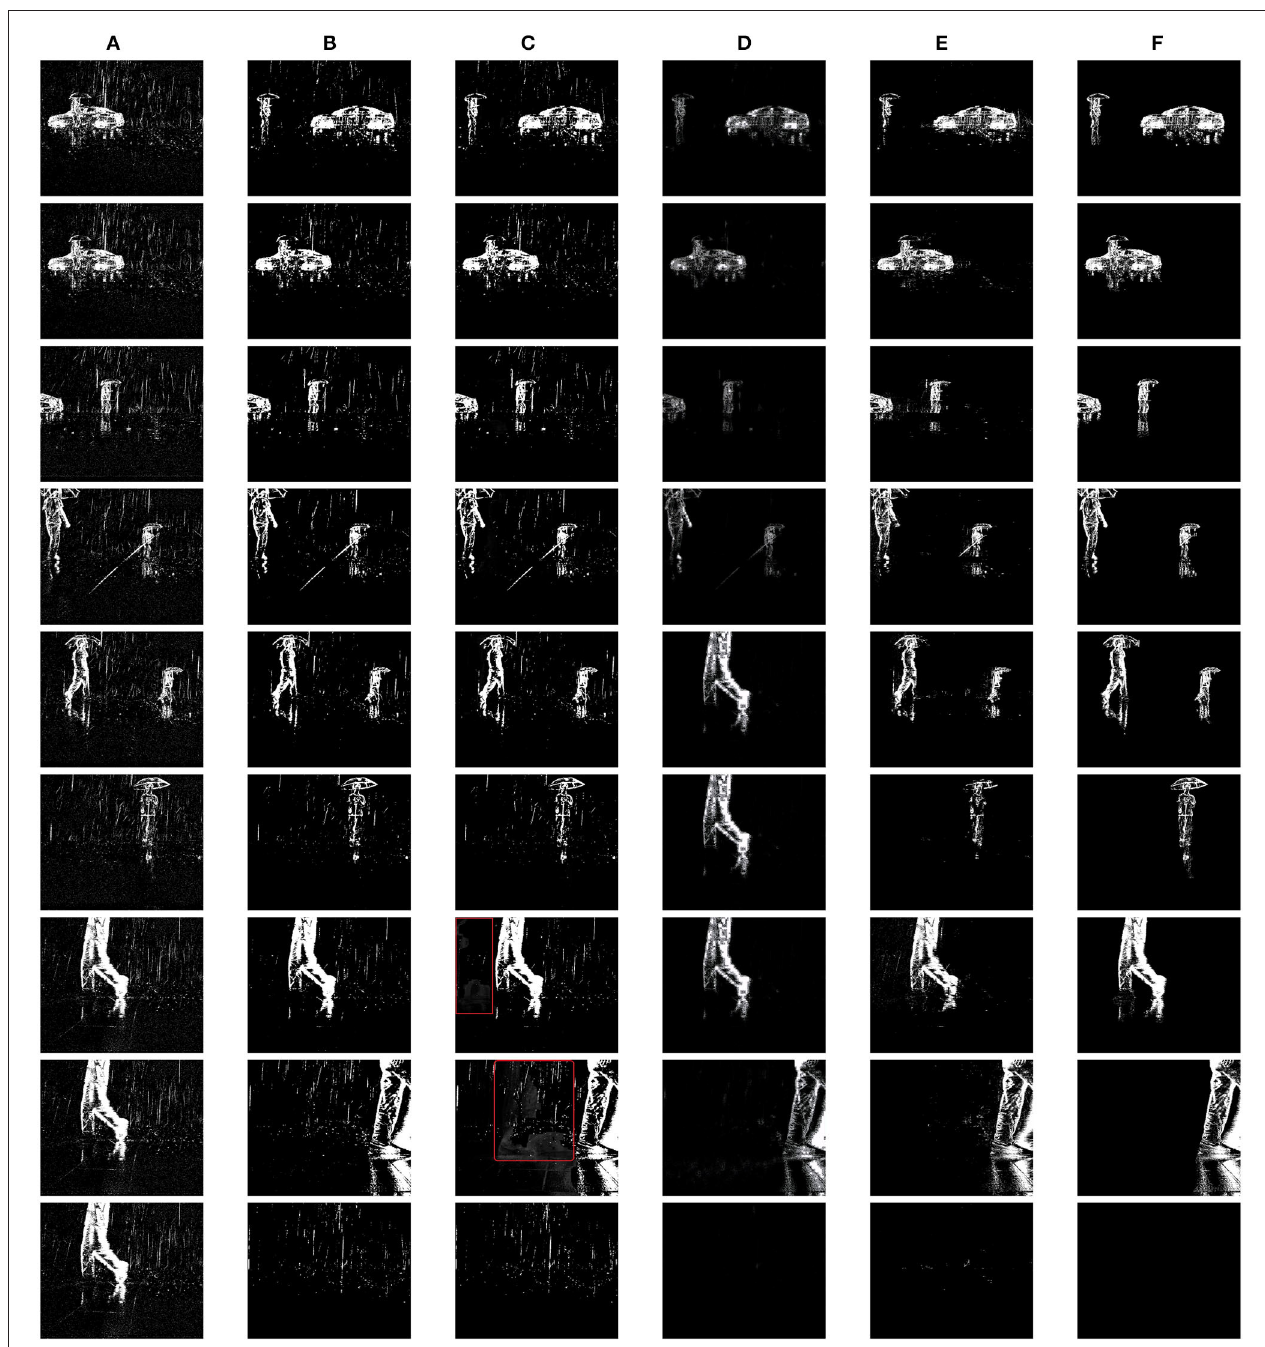
FIGURE 6 | The rainy input, rain removal results by different methods, and the ground truth (GT) of nine different frames. WTSD is our approach while MCSC, PMG, and ReMAEN are the ones for comparison. Note the part framed in red of PMG results. (A) Input. (B) MCSC. (C) PMG. (D) ReMAEN. (E) WTSD. (F)